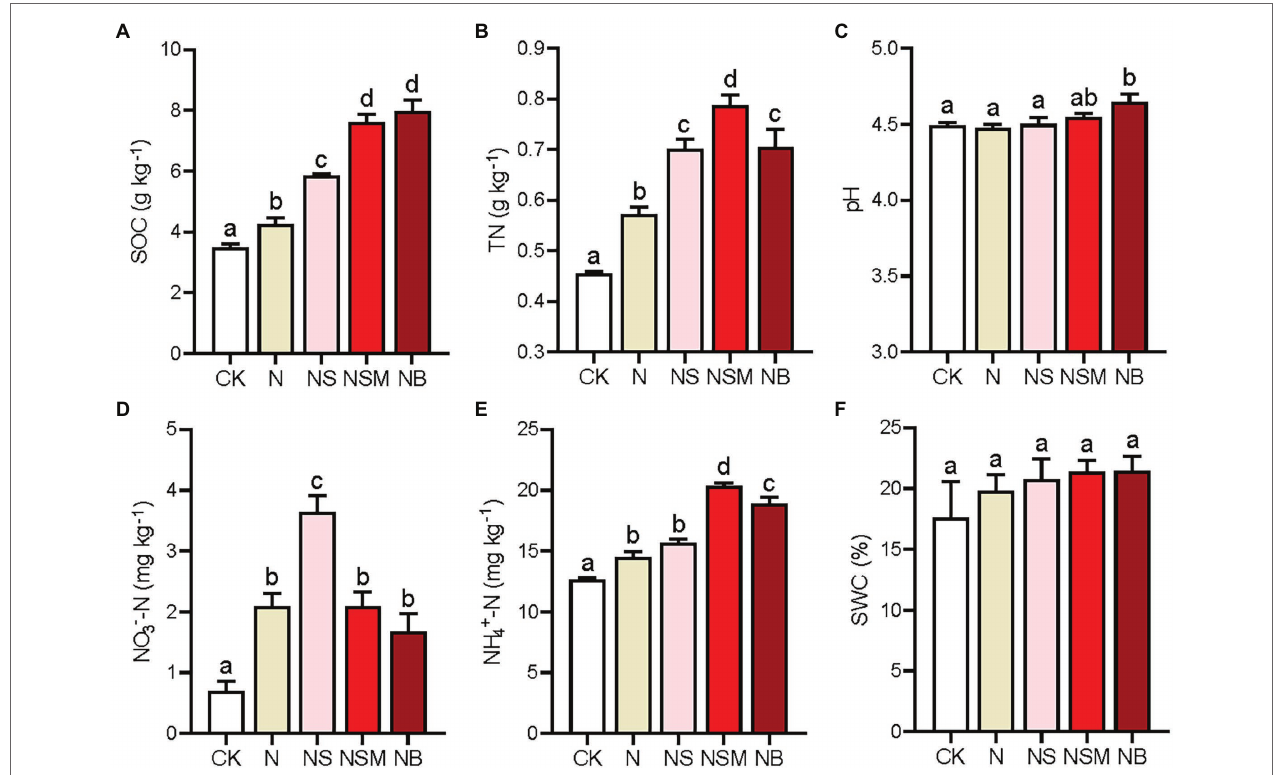
FIGURE 1 | Chemical properties of the rhizosphere soils under the five fertilization treatments, including soil organic carbon (SOC, A ), total nitrogen (TN, B ), pH (C) , nitrate nitrogen (NO 3 − -N, D ), ammonia nitrogen (NH 4+ -N, E ), and soil water content (SWC, F ). Different lowercase letters indicate significant differences based on Tukey’s HSD test ( p < 0.05). CK, no fertilizer; N, NPK fertilizer; NS, NPK fertilizer and straw; NSM, NPK fertilizer and straw combined with pig manure; NB, NPK fertilizer and straw biochar.